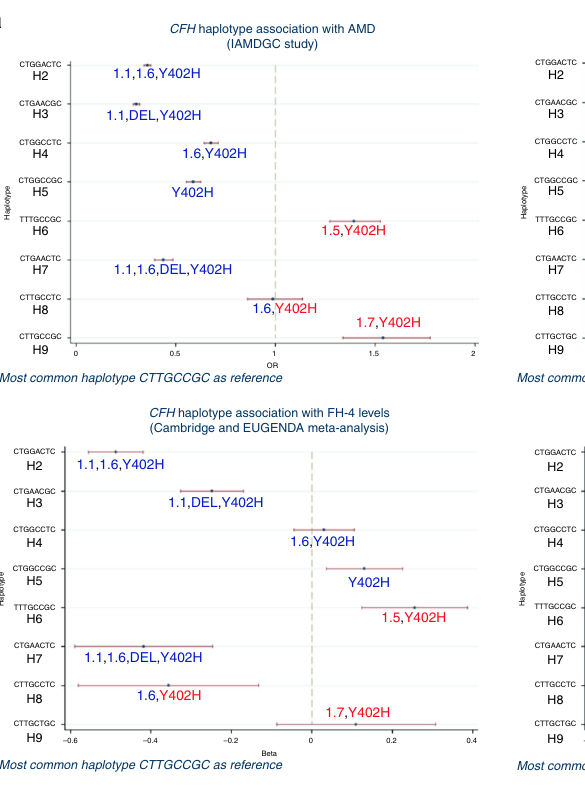
frequencyIAMDGC CasesHaplotype ControlsCases